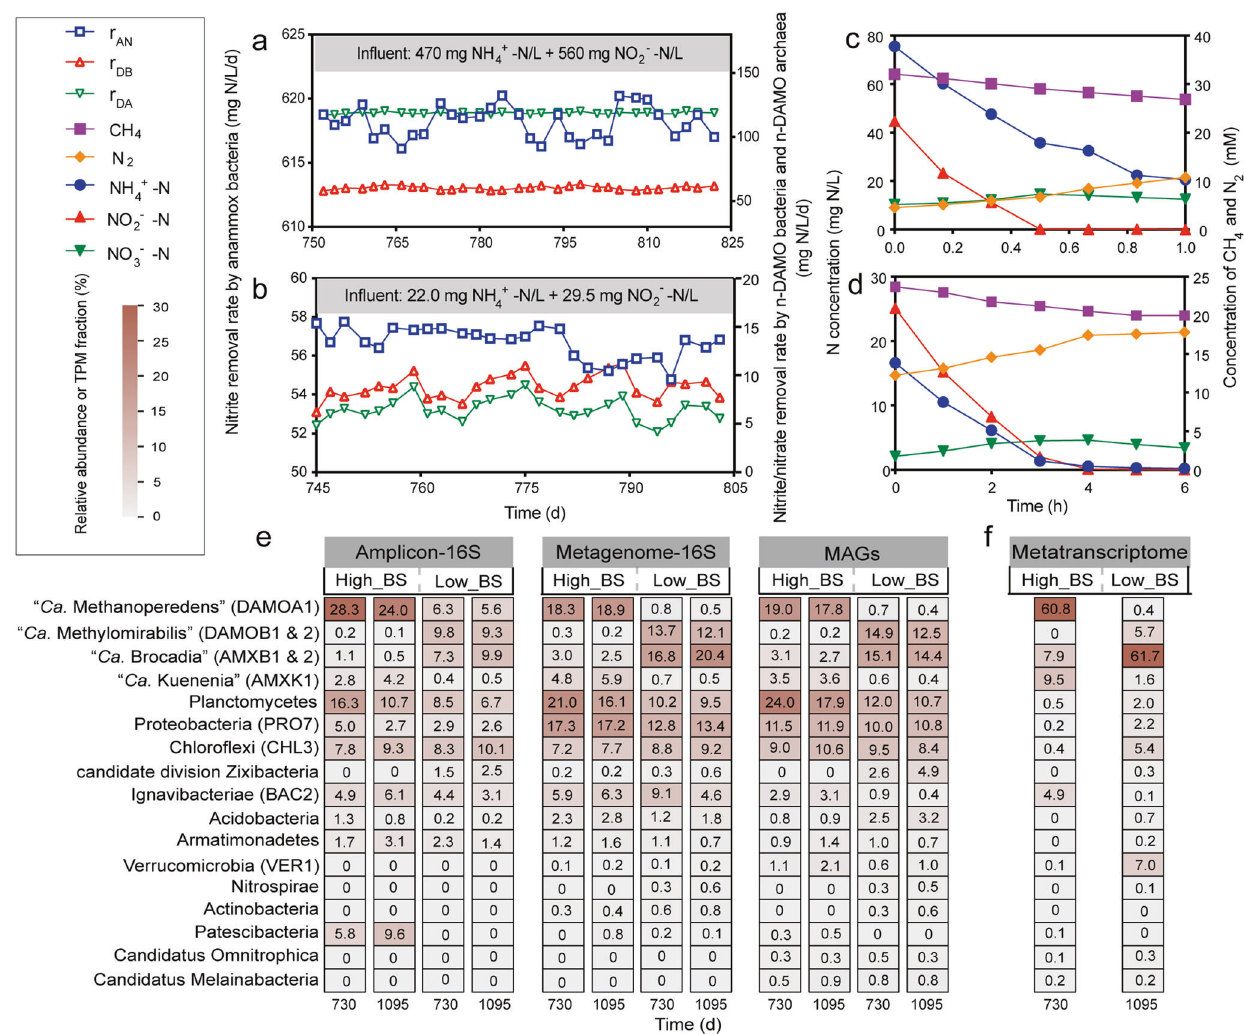
Fig. 1 Nitrogen removal performance and microbial community pro fi les of High_BS (high loading) and Low_BS (low loading). Species- speci fi c nitrogen conversion rates during the long-term operation of High_BS ( a ) and Low_BS ( b ): nitrite removal rate by anammox bacteria (r AN ), nitrite removal rate by n-DAMO bacteria (r DB ), and nitrate removal rate by n-DAMO archaea (r DA ). Batch tests were performed on day 974 to validate the variations of nitrogenous substrates and methane of High_BS in 1 h ( c ) and of Low_BS in 6 h ( d ). e Microbial community structures of High_BS and Low_BS were revealed from 16S rRNA gene amplicon sequencing data, 16S rRNA genes from the metagenomic reads and recovered MAGs. f Relative expression of MAGs. DAMOA1 is the only MAG of n-DAMO archaea af fi liated with “ Ca . M. nitroreducens ” , while DAMOB1 and DAMOB2 are the MAGs of n-DAMO bacteria belonging to “ Ca . Methylomirabilis ” . AMXK1, AMXB1 and AMXB2 are anammox MAGs. BAC2, VER1, CHL3 and PRO7 are MAGs with expression above 1% in either High_BS or Low_BS, belonging to Bacteroidota, Verrucomicrobiota, Chloro fl exota and Proteobacteria, respectively. Numbers in the cell indicate the relative abundance or TPM